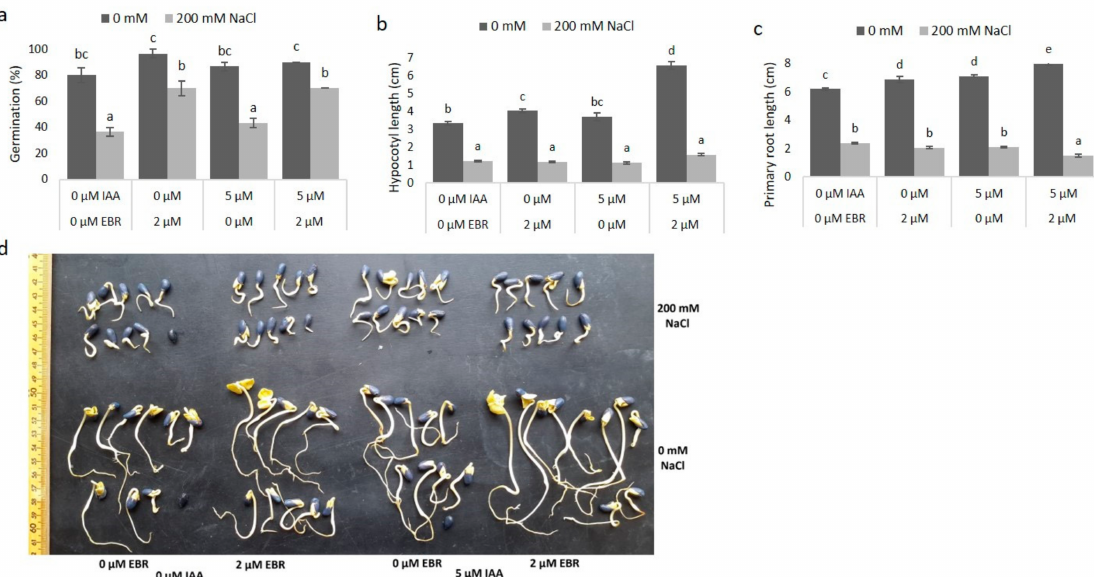
Figure 5. Cotton seed germination and seedling growth under salt stress following treatment with either EBR or IAA alone or together. Percent germination ( a ); hypocotyl length ( b ); primary root length ( c ); and seedling phenotypes ( d ), in response to pre-treatment with EBR (0 and 2 µ M), IAA (0 and 5 µ M) and IAA plus EBR (as indicated in figures) under 0 and 200 mM NaCl were recorded on the 4th and 13th days, respectively. Error bars represent standard error (SE) of the mean for three replicates ( n = 30). Different letters above the bars indicate significant differences in two-way ANOVA ( p < 0.05) followed by Tukey’s post hoc test.